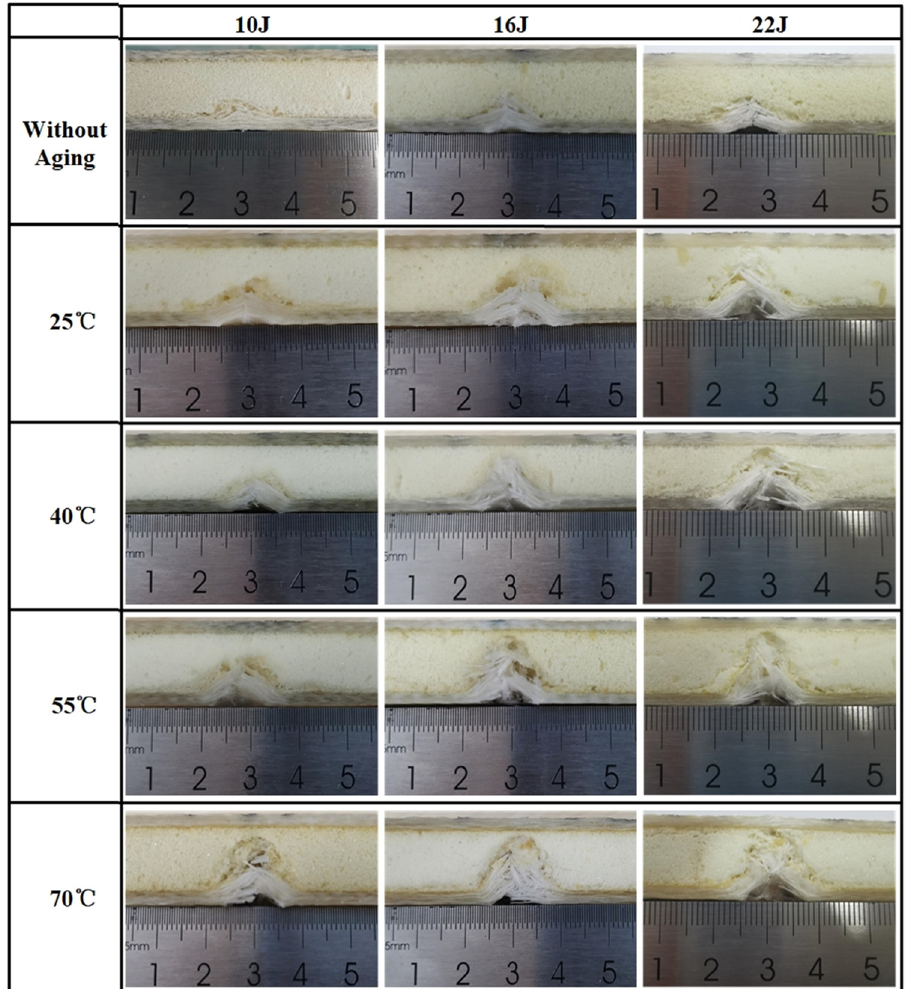
Figure 10: Cross - section damage morphology of sandwich panels 25°C – 0 days, 25°C – 30 days, 40°C – 30 days, 55°C – 30 days, and 70°C – 30